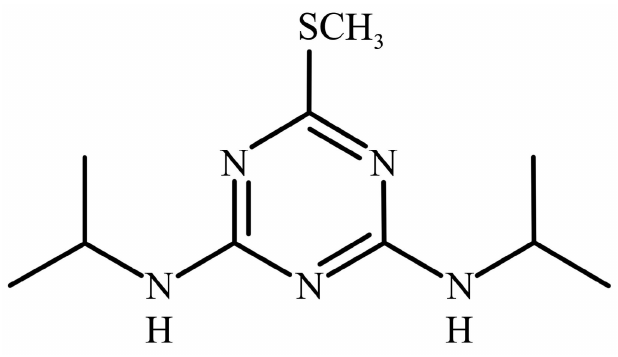
Figure 1. Prometryne chemical